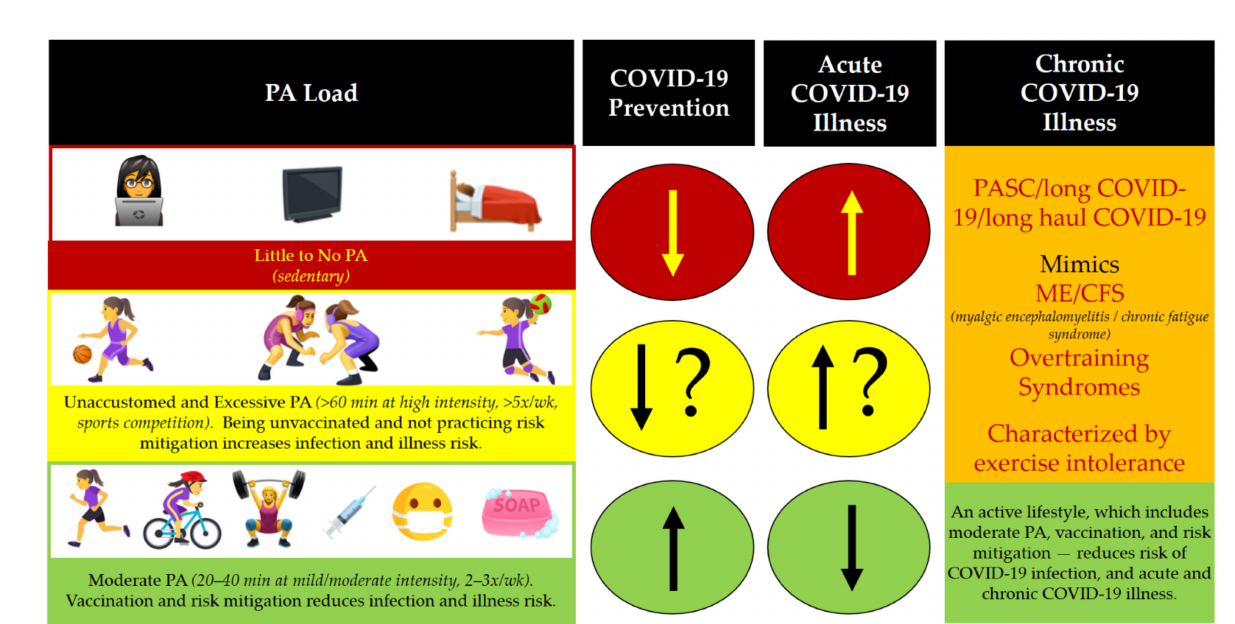
Figure 3. PA, COVID-19 infection and illness, and population health. Following an active lifestyle, which prioritizes preventive healthcare in the form of moderate levels of PA, vaccination when eligible, and continued COVID-19 risk mitigation, would likely help women in optimizing their mental and physical health and reduce their risk of COVID-19 infection and illness. The health of women in societies is of critical importance during the COVID-19 pandemic due to the pivotal roles women play in commerce, healthcare, and family health and